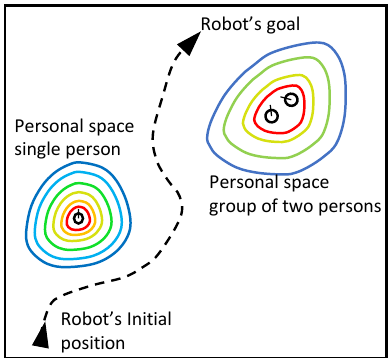
Figure 15. HRP aware path planing strategy proposed in